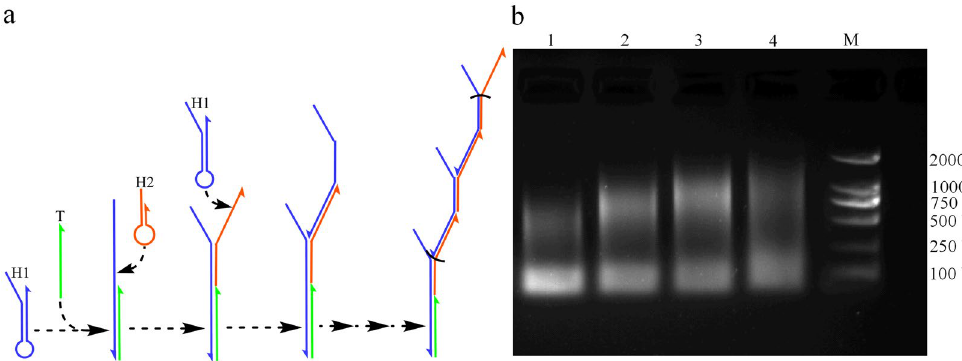
Figure 3. ( a ) The principle of basic HCR system. H1 and H2 were two stable species of DNA hairpins, and T was a single-stranded DNA target used as an initiator. ( b ) Agarose gel electrophoresis of HCR products. Each reaction was 10 μ L (10 mM PBS, 5 mM MgCl 2 , pH 7.4) and incubated for 15 min at room temperature. Lane 1. 0.5 μ M H1 + 0.5 μ M H2 + 0.1 μ M target DNA; Lane 2–4. 10%, 20%, 40% PEG 200 were added on the basis of Lane 1, respectively; Lane M. DL 2000 bp DNA